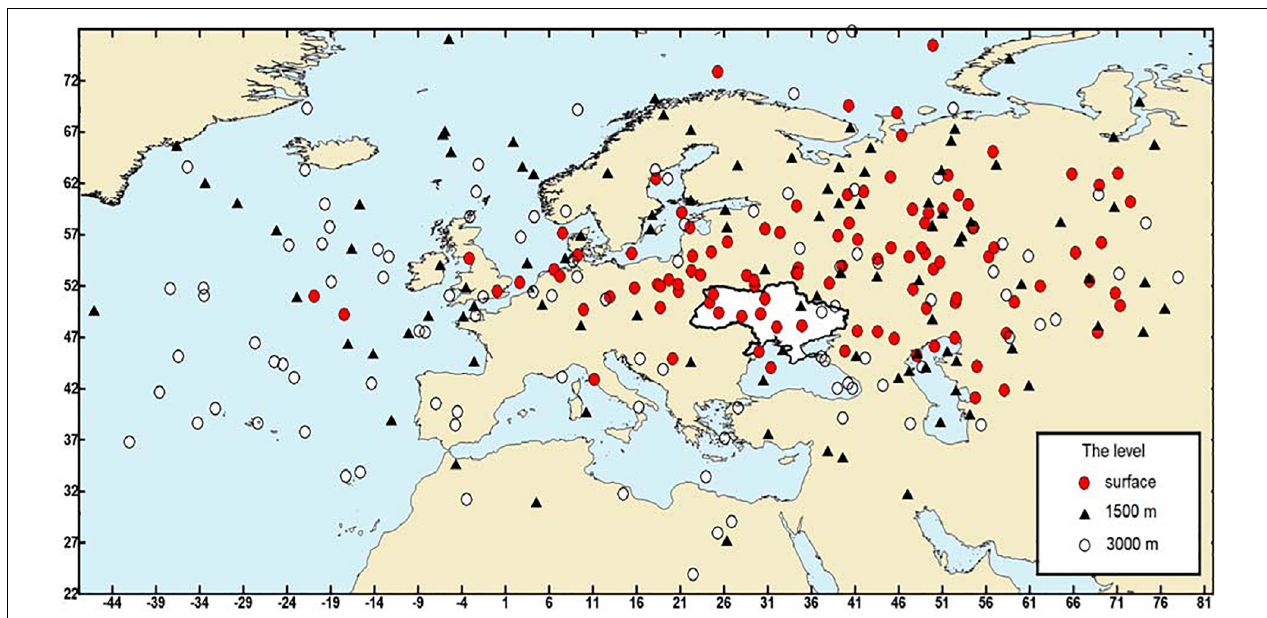
FIGURE 5 | Initial points of 5-day backward trajectories of air masses particles for periods with dry winds at the meteorological stations located in the Black Sea Steppe